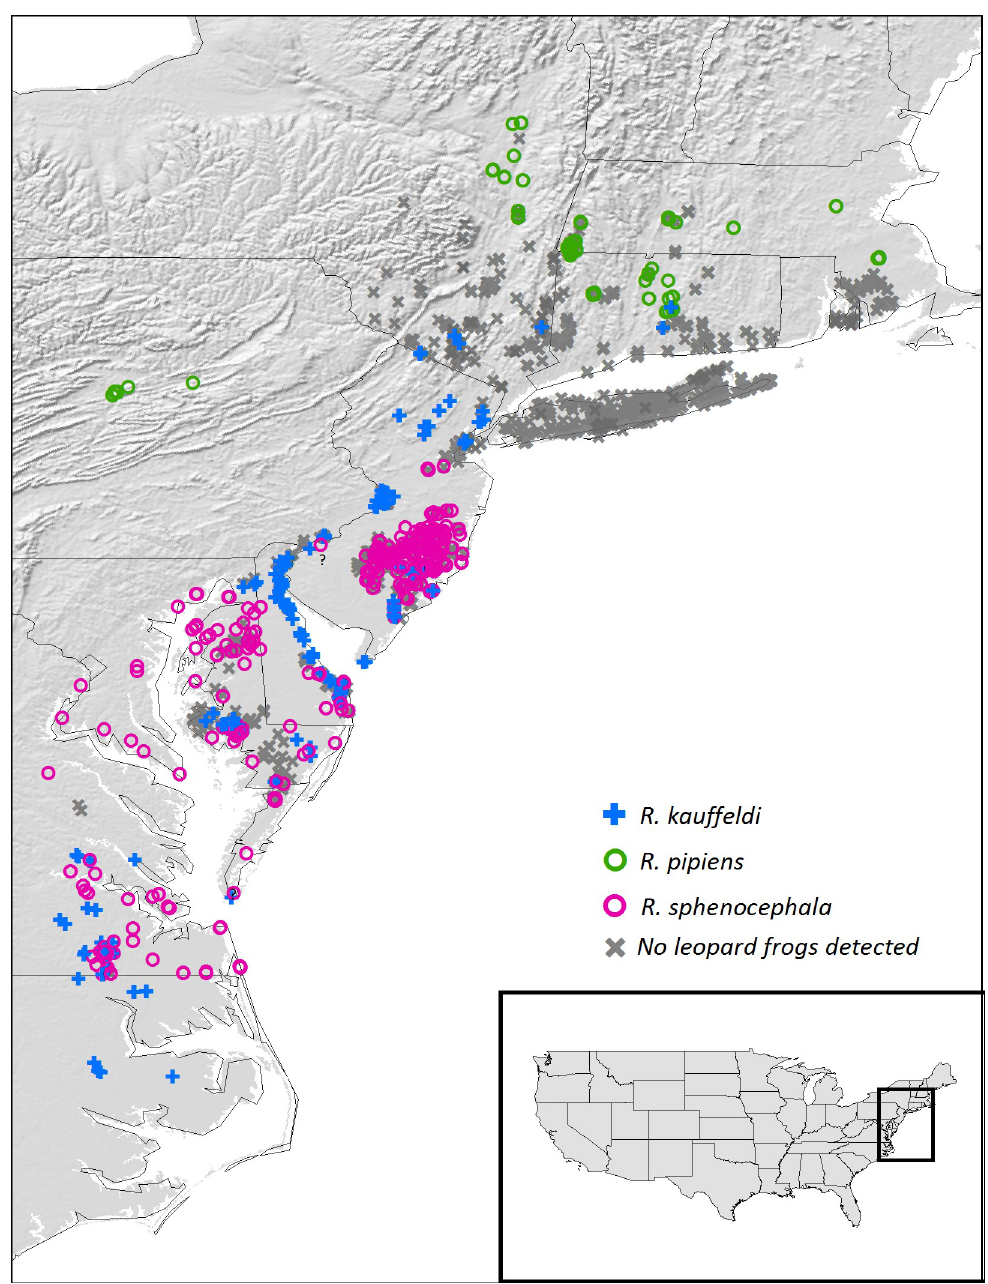
Fig 2. Leopard frog presence and non-detections from call surveys and genetic analysis in the northeastern U.S. Question marks are directly below presence points where identifications from genetic analysis were questionable. Shaded relief map from